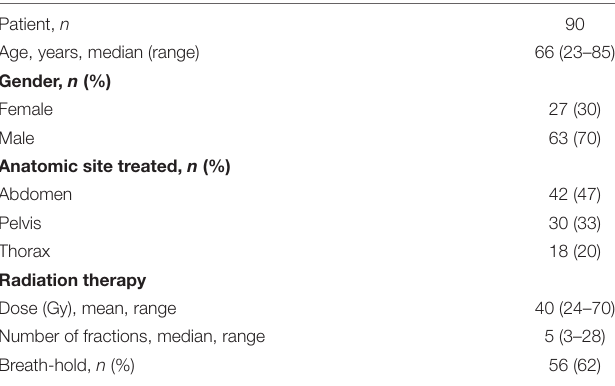
TABLE 2 | Demographic and clinical characteristics of the patients.